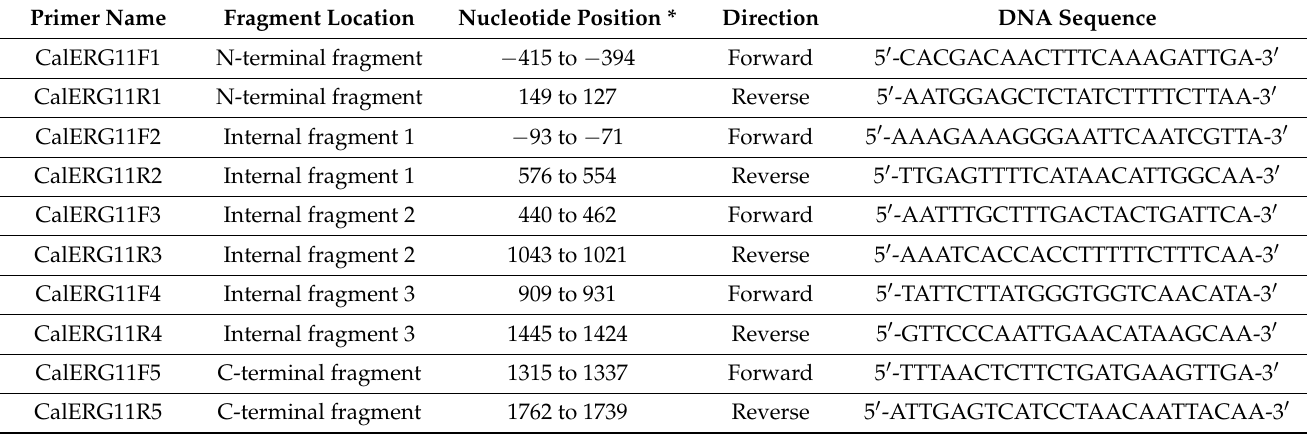
Table 2. The DNA sequences of forward and reverse primers and their location in ERG11